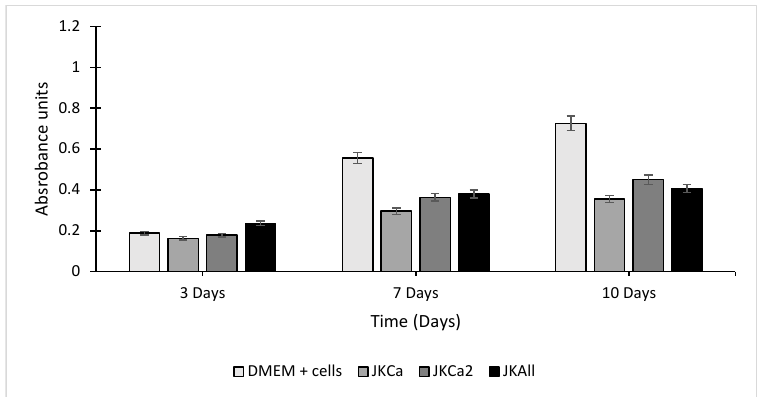
Figure 9. Cytotoxicity assay (MTT) of swine pulp cells seeded (4000 cell/well) with jarosite powders after 3, 7 and 10 days. Results are expressed as the mean and standard deviation of the cell viability.